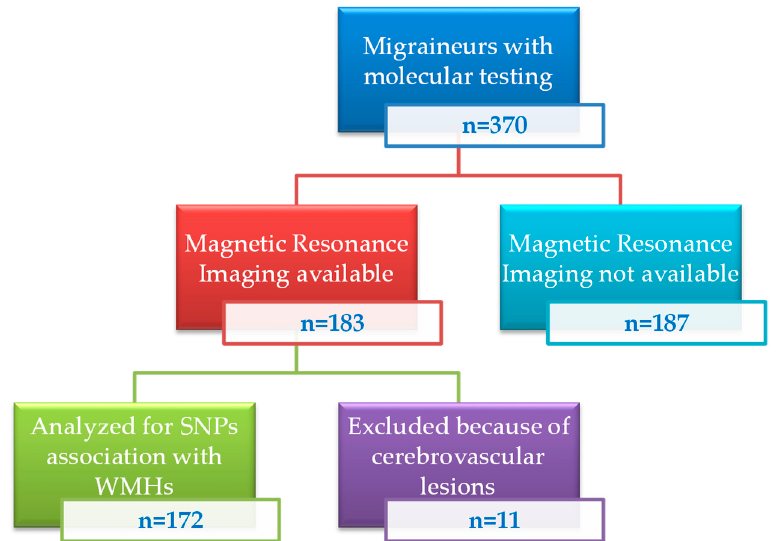
Figure 1. Flow chart of patients’ recruitment.